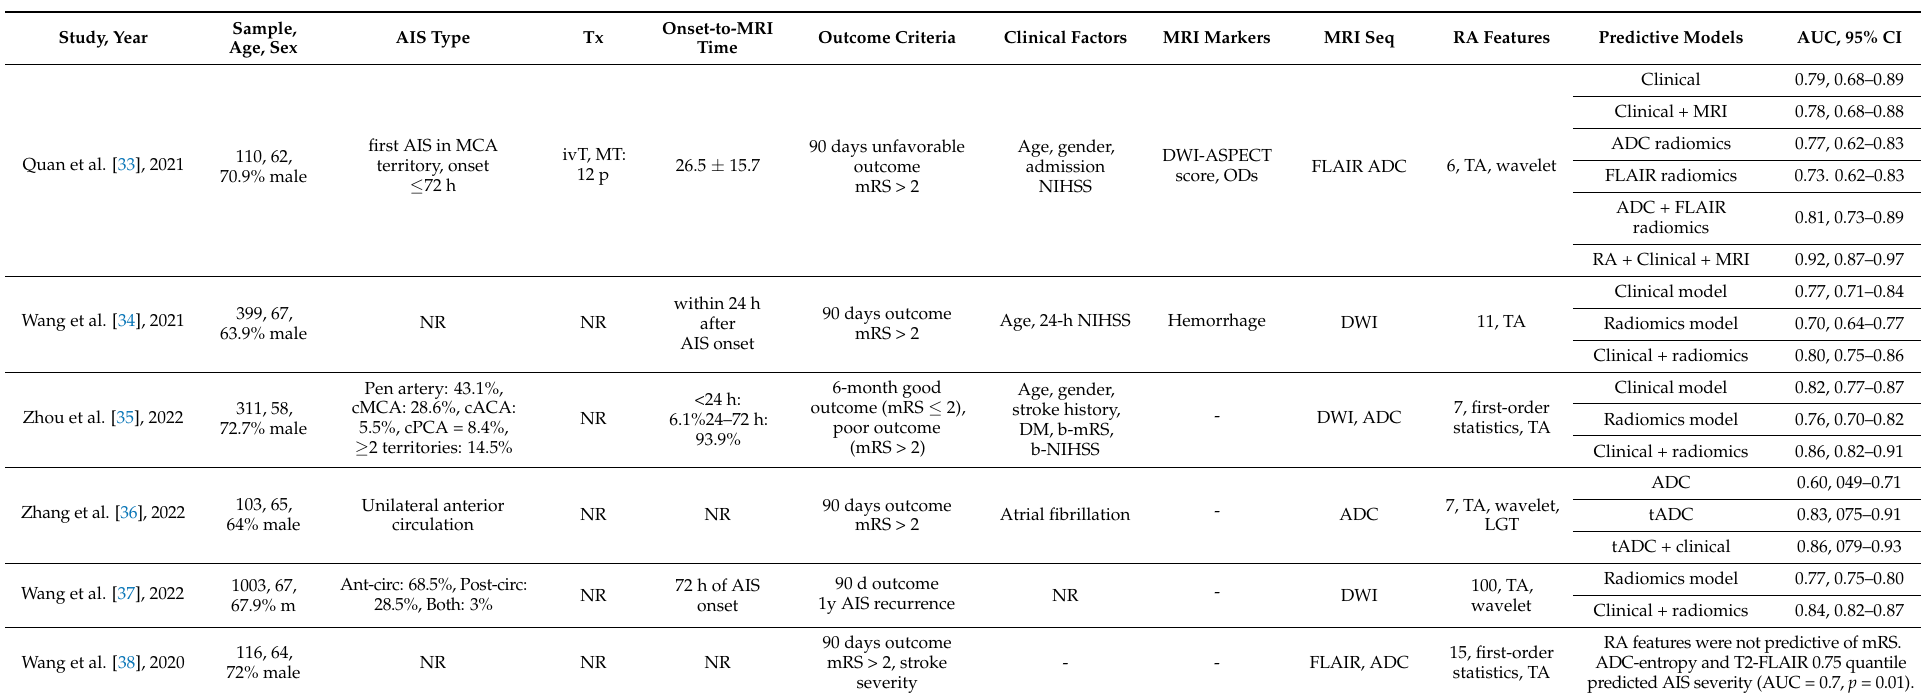
Table 2. Characteristics of studies included in systematic